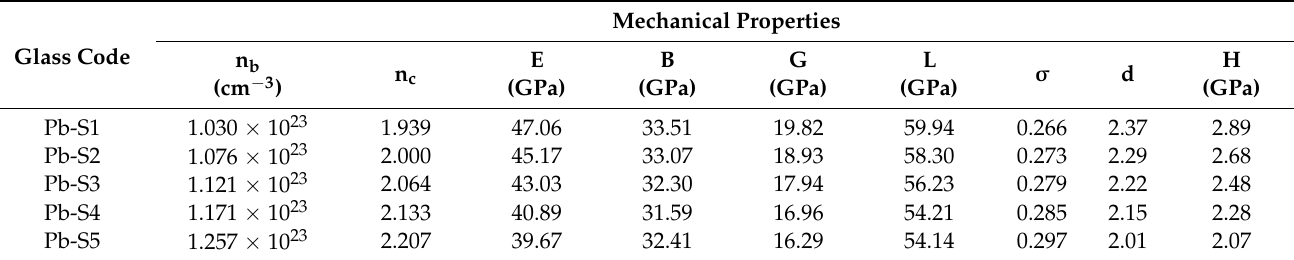
1.030 × 10 23 cm − 3 to 1.257 × 10 23 cm − 3 . The increase in PbO content increases the